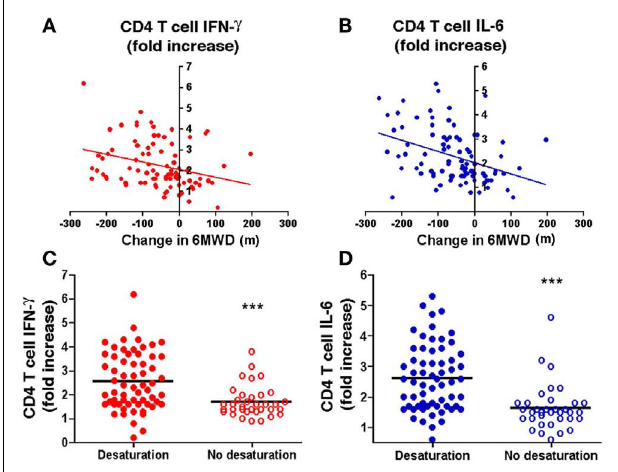
Table 1 | Sensitivity and specificity of cytokines in CD4T cell.